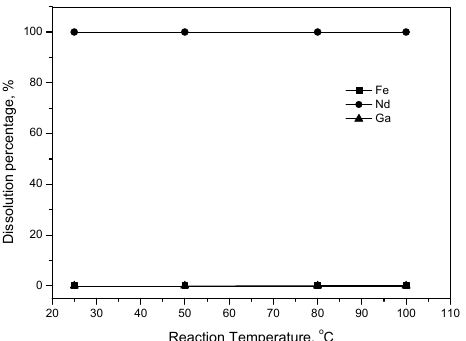
Figure 4. Effect of temperature on the leaching of oxide mixtures by 0.05 M H 2 SO 4 in EG. Operation conditions: pulp density = 50 g/L, time = 90 min, stirring speed = 400 rpm.